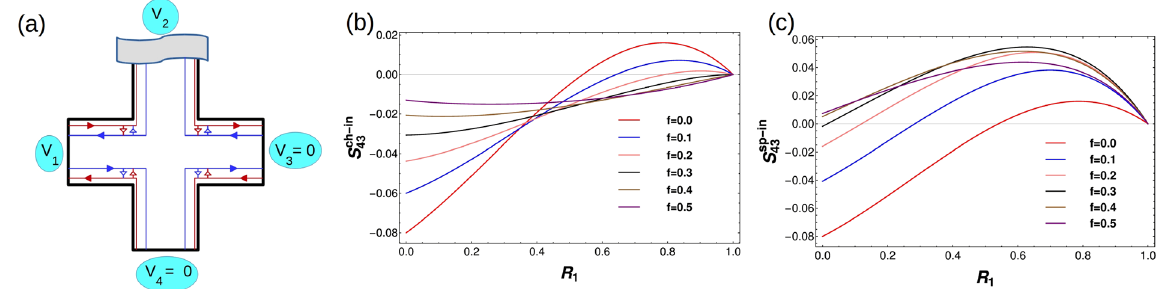
Figure 7. ( a ) QSH sample with trivial quasi-helical edge modes. There are two disordered probes with inelastic scattering included via voltage probe 2, small arrowheads indicate intra edge scattering. The effect of such intra- edge scattering on positive non-local charge ( b ) and spin ( c ) correlations. Non-local charge ( b ) ( − S ch in spin ( c ) correlations ( S sp in 43, vs R ) in a trivial quasi-helical QSH sample with two disordered probes ( = . R 0 2 1 and inelastic scattering. Note the exactly opposite behavior to the nonlocal charge correlations. The intra edge scattering parameter: = f 0(topological) (red) and = . f 0 1 (blue), = . f 0 2 (pink), = . f 0 3 (black), = . f 0 4 (brown), = . f 0 5 (purple) in ( b , c